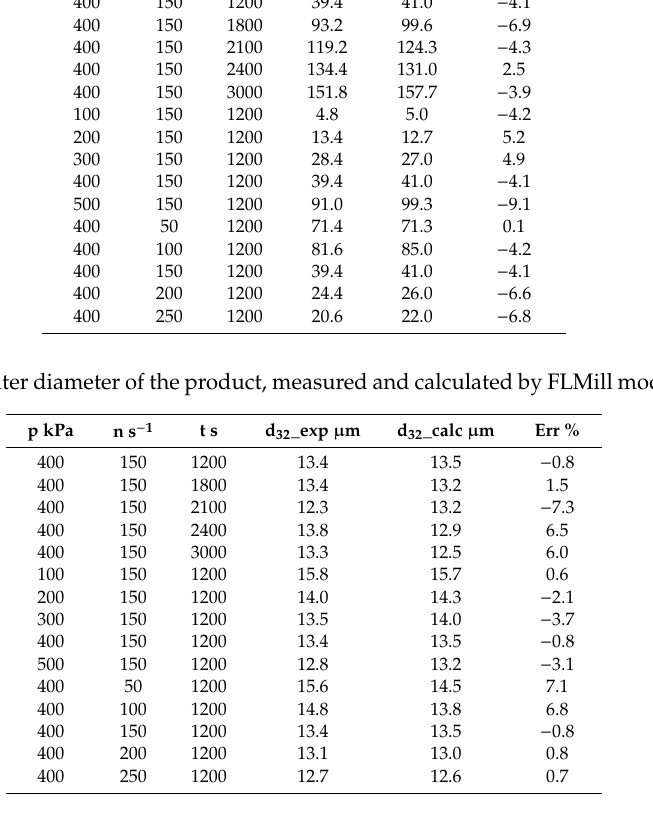
Table A1. Mass of grinding product, measured and calculated by FLMill model (SSE = 208.49). p kPa